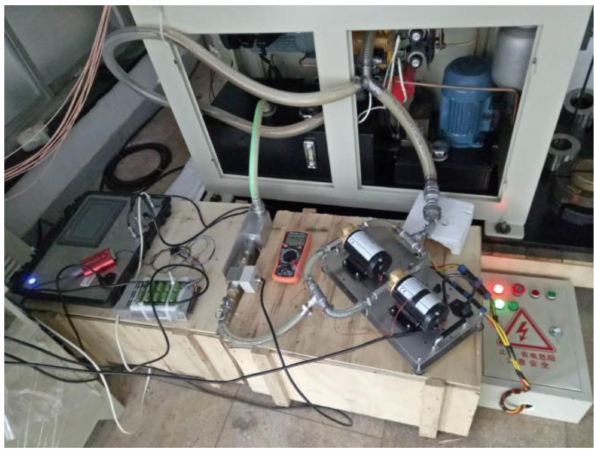
Figure 8. The OOMS and oil circulation loop.